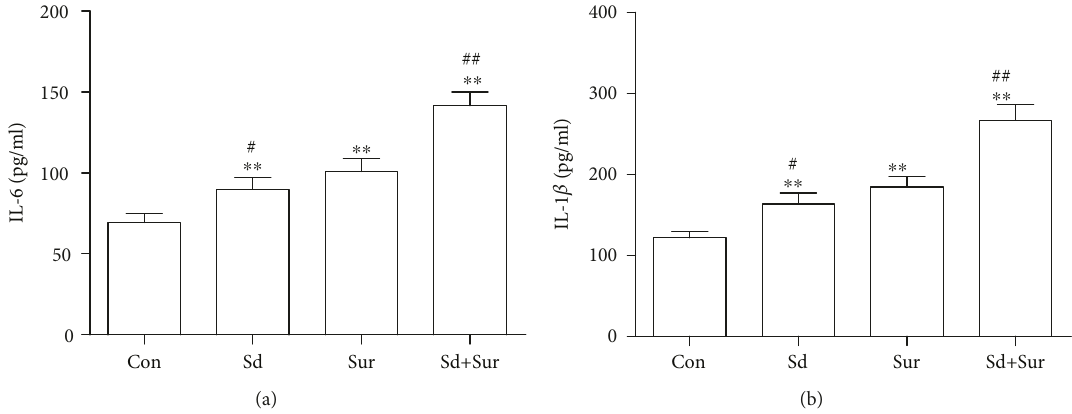
Figure 3: Preoperative sleep disturbance promoted the surgery-induced increase of IL-6 and IL-1 β levels in the hippocampus. (a) Levels of IL-6 in the hippocampus as detected by ELISA. (b) Levels of IL-1 β in the hippocampus as detected by ELISA. The data are presented as the mean ± sem ( n = 6 ). ∗∗ P < 0 01 vs. the Con group; # P < 0 05 and ## P < 0 01 vs. the Sur group.